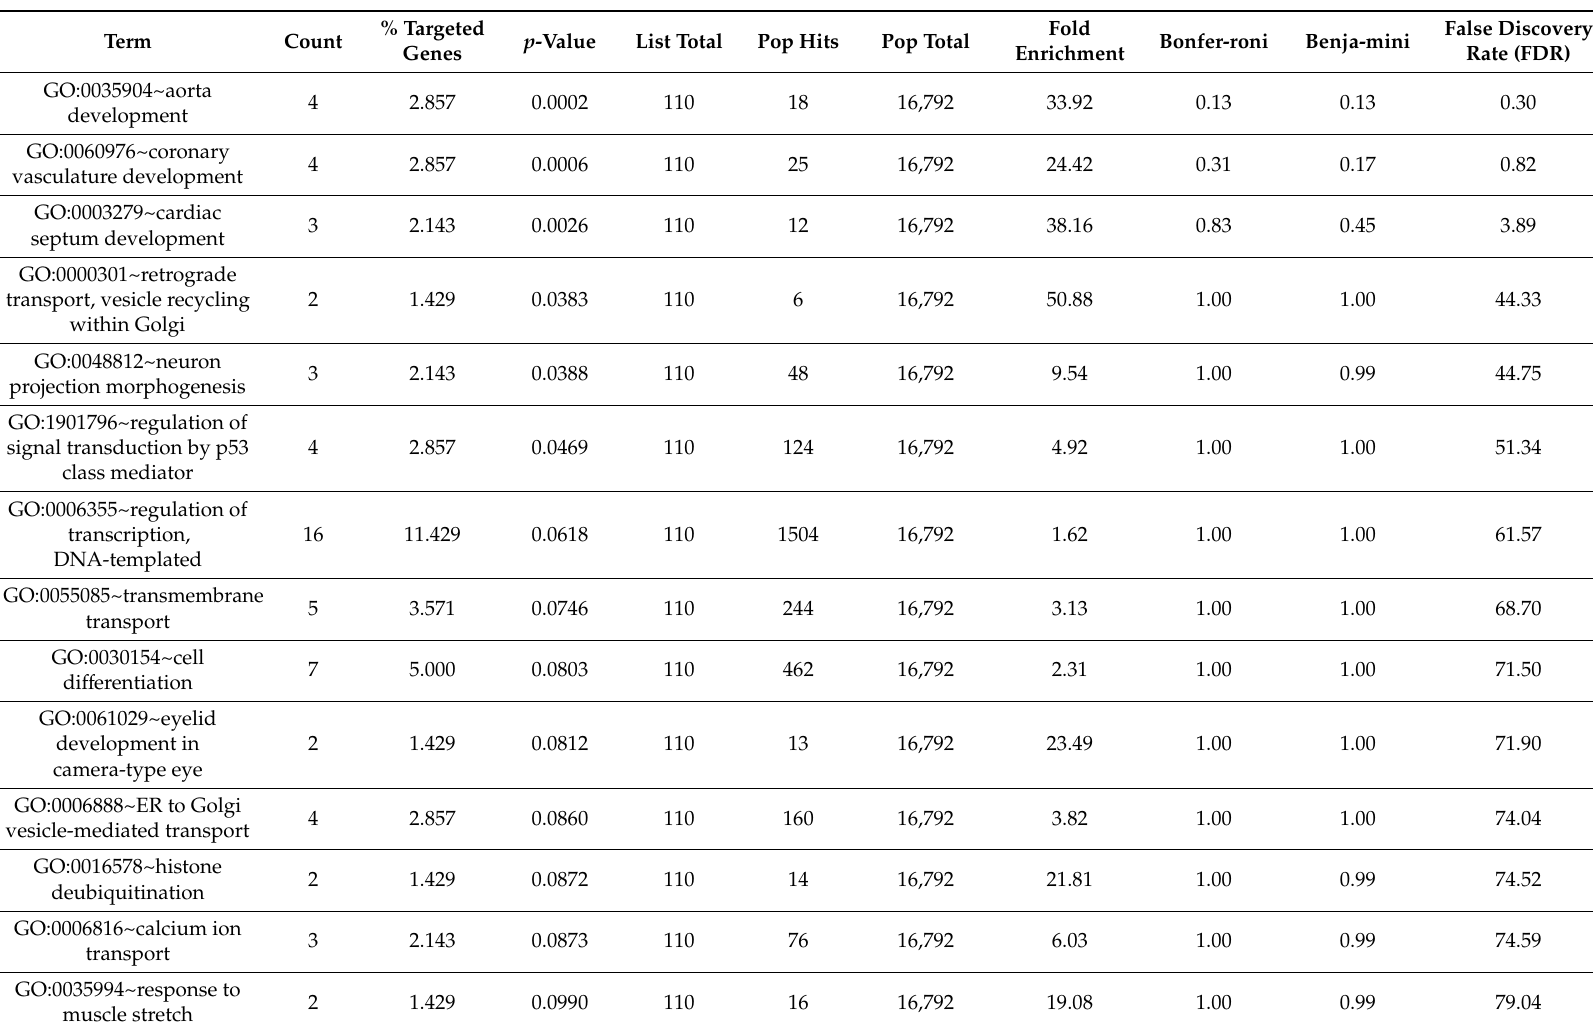
Table 2. Signaling pathways identified from biological process gene ontology (GO) enrichment using DAVID based on targeted genes predicted using miRanda